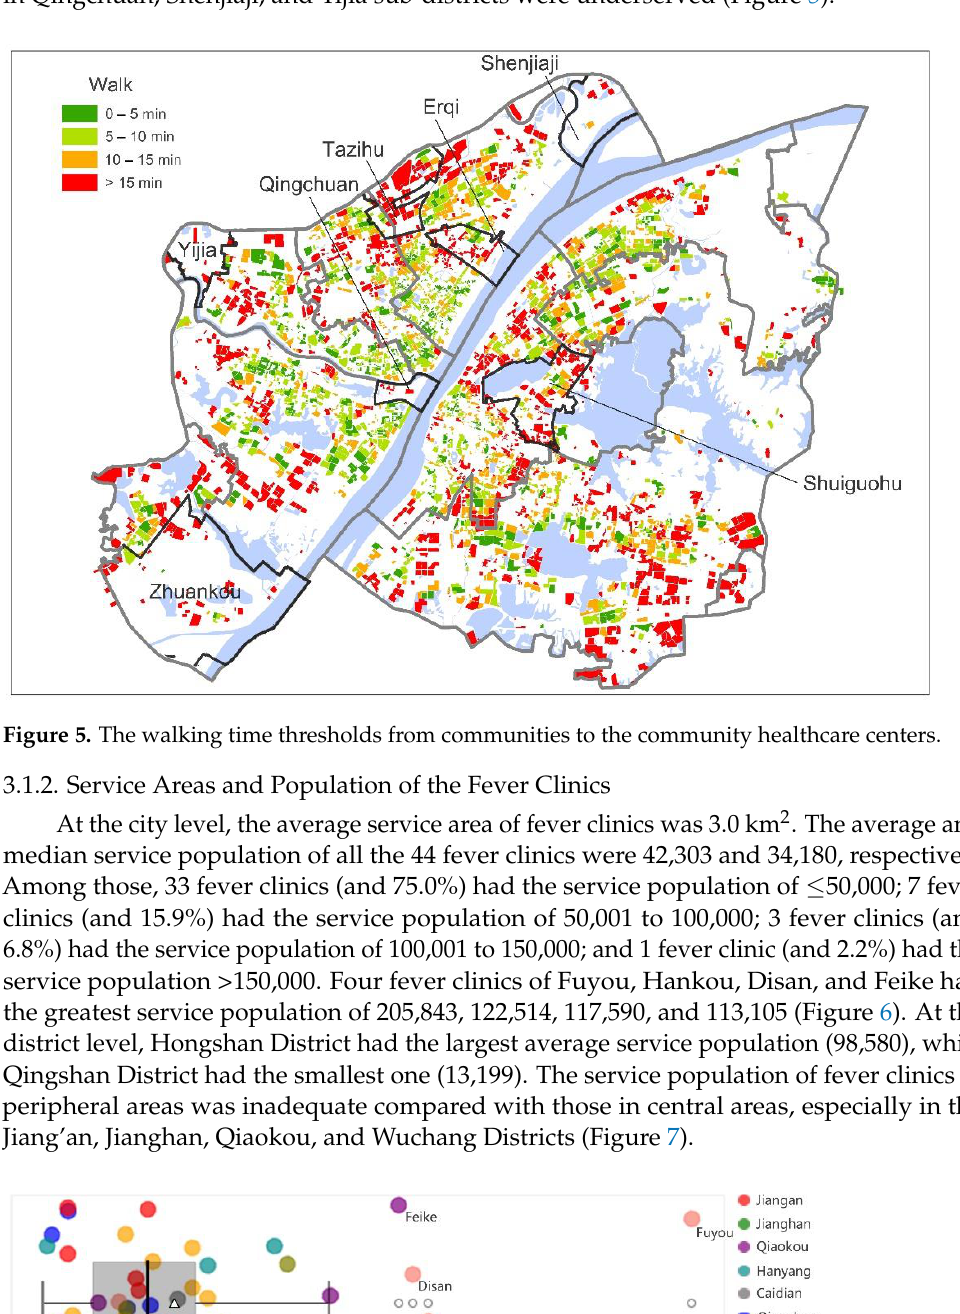
Figure 7. Service areas (in different colors) and service population (in different sizes) of the fever clinics. 3.1.3. Service Areas and Population–Hospital Bed Ratios of the Designated Hospitals At the city level, the average service area of designated hospitals was 3.8 km 2 . The average and median population–hospital bed ratios, defined as the ratio between the total population and total number of hospital beds, were 149 and 115, respectively. The larger